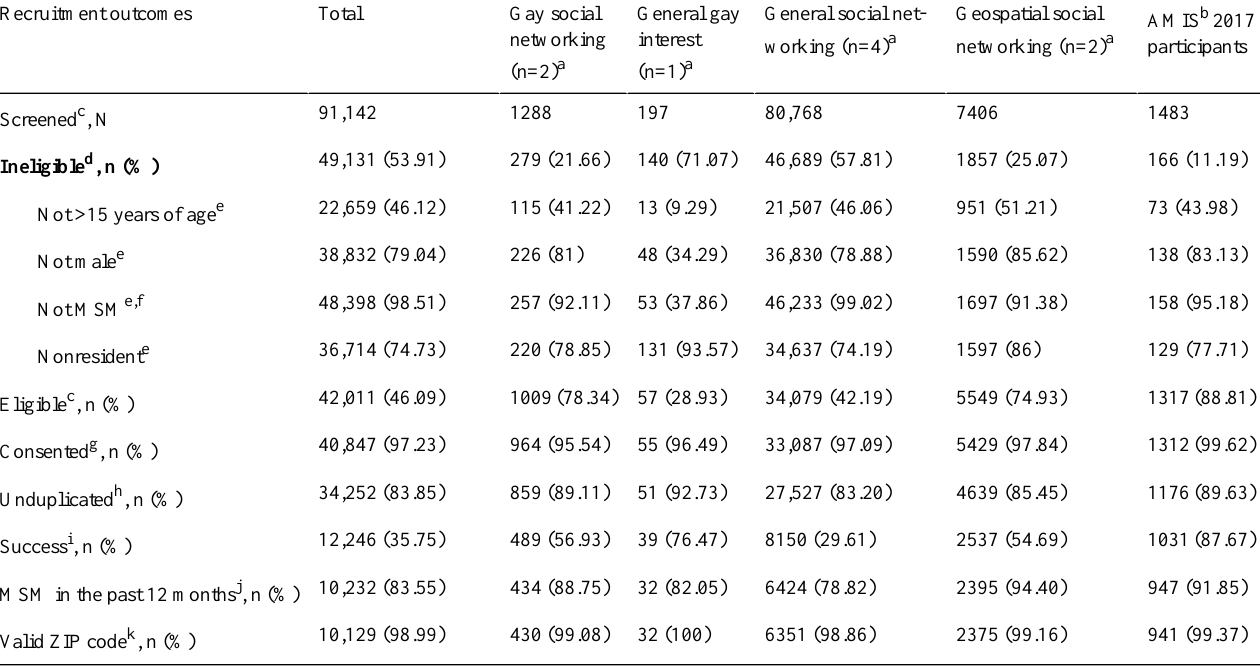
Table 1. Recruitment outcomes for the American Men’s Internet Survey, United States,